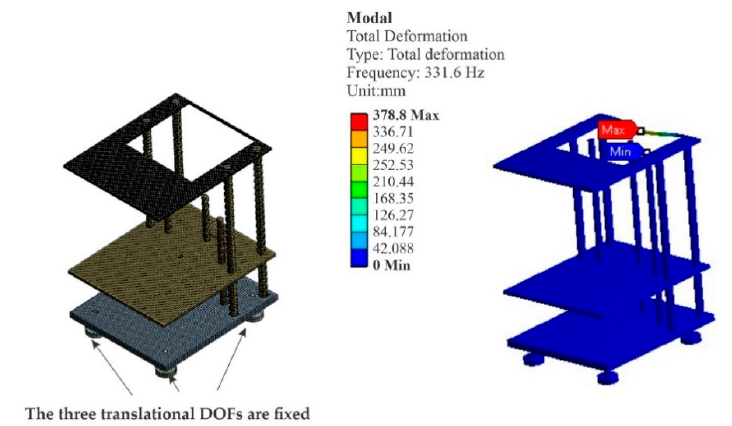
Figure 9. Total deformation—structure of steel plates and rods.